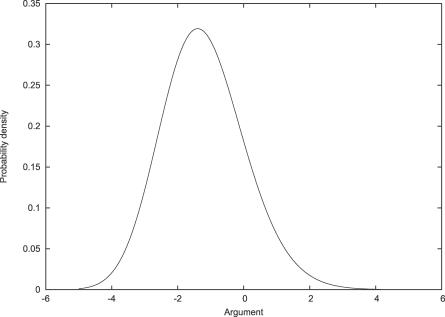
The Tracy–Widom DensityConventional percentile points are: P = 0.05, x = .9794; P = 0.01, x = 2.0236; P = 0.001, x = 3.2730.